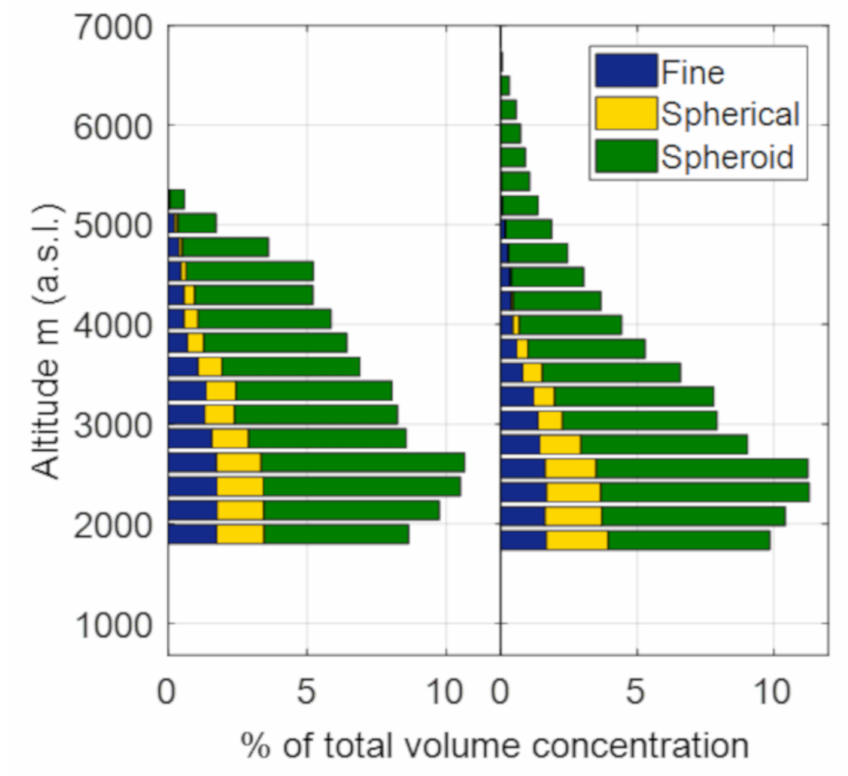
Figure 3. Percentage of the total volume concentration distributed by layers of 250 m. The lengths of the bars indicate the contribution of every 250-m layer to the total volume concentration. The total volume concentration is calculated as the sum of the 112 profiles during the whole analysed period and the sum of the values for the entire vertical profiles. Inside each bar, the di ff erent colors (blue, red, green) indicate the apportionment to the total volume concentration in the corresponding height range by fine, coarse spherical and coarse spheroid modes,